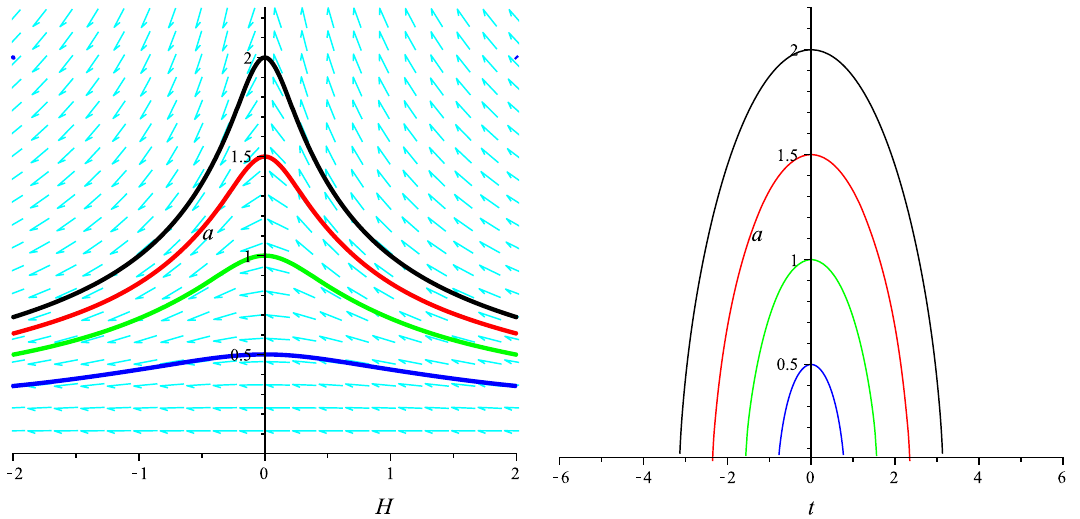
Fig. 7 (Left) phase plane of parameters ( a , H ) for the case of k = 1 ,α = 0 ,β = 0. (Right) time evolution of the scale factor corresponding to the highlighted trajectories of the phase